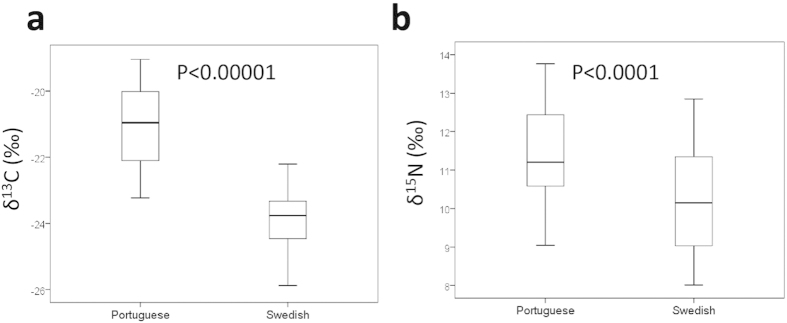
Boxplots showing (a) δ13C levels (P < 0.00001) and (b) δ15Ν levels in carotid plaques from Portuguese and Swedish patients (P < 0.0001).